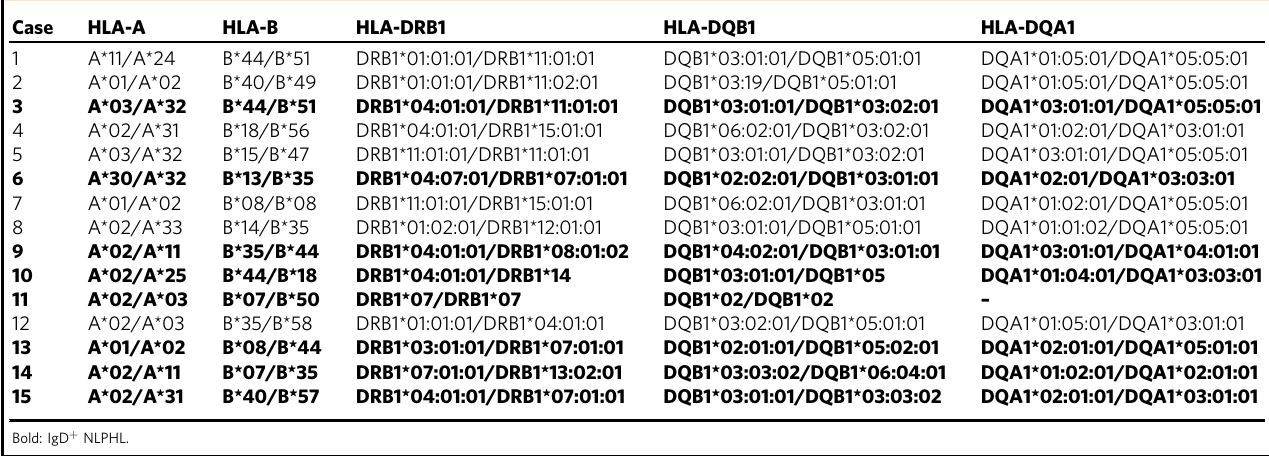
Table 3 MHC alleles of NLPHL.